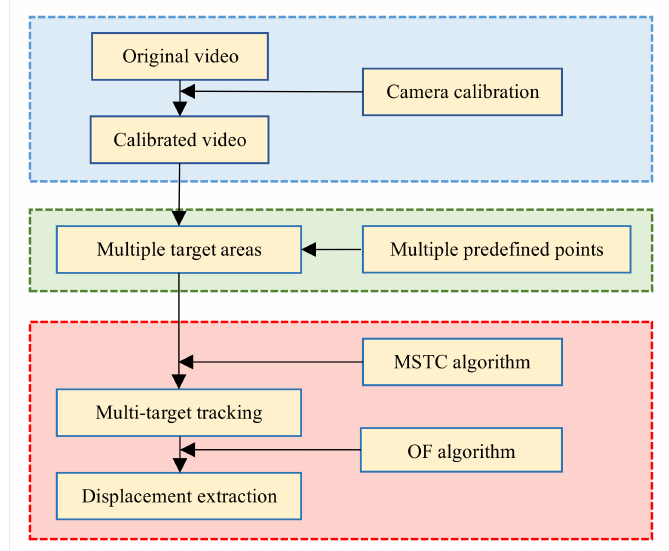
Figure 1. Flowchart of multi-displacement measurement with